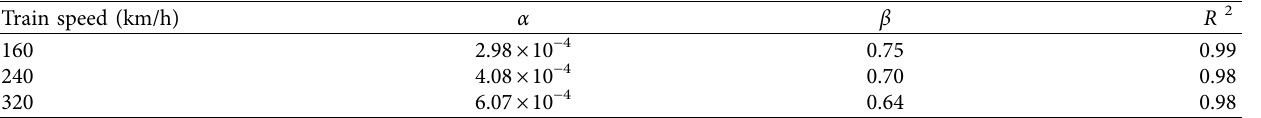
Table 4: Fitting